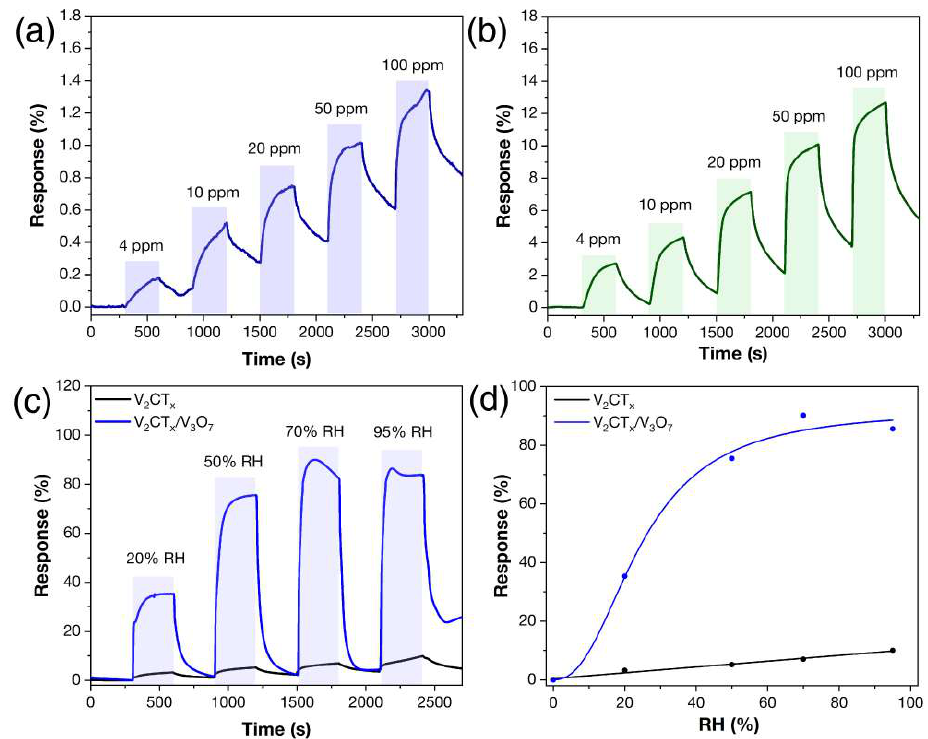
Figure 7. Responses (%) to 4–100 ppm NH 3 of V 2 CT x MXene film before ( a ) and after oxidation ( b ) at RT and 0%RH; responses to 20–95%RH ( c , d ) at RT.